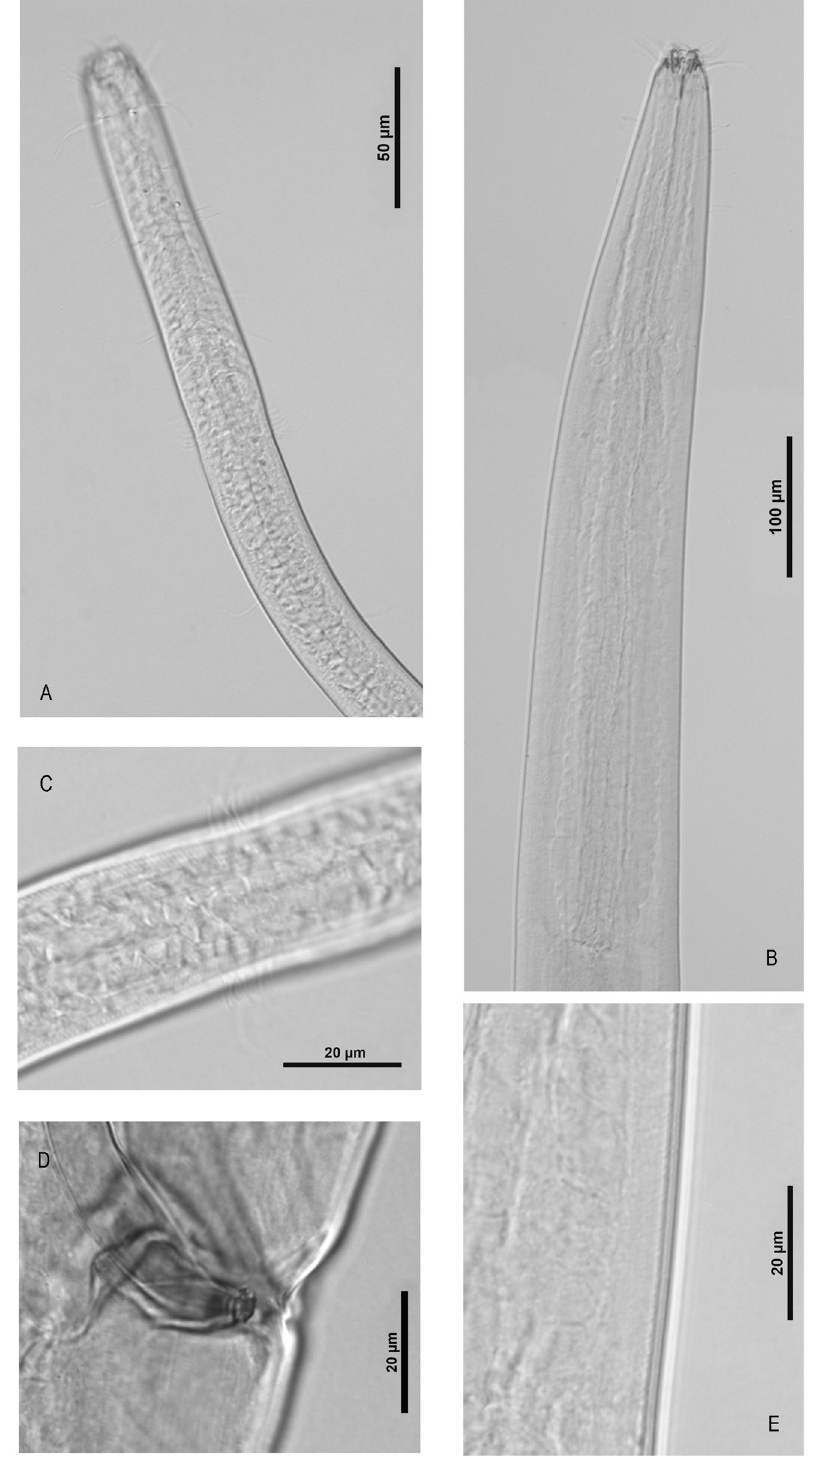
Fig. 5. A . Pharyngeal region of Mesacanthion longigubernaculum sp. nov., ♂, holotype (CNP-NEM 27442). B . Pharyngeal region of M. sanantoniensis sp. nov., ♂, paratype (CNP-NEM 848). C . Detail of M. longigubernaculum sp. nov., ♂, holotype (CNP-NEM 27442), showing cuticular striation. D . Gubernaculum of M. bifidum sp. nov., ♂, holotype (CNP-NEM 936). E . Detail of M. sanantoniensis sp. nov., ♂, paratype (CNP-NEM 848), showing cuticular